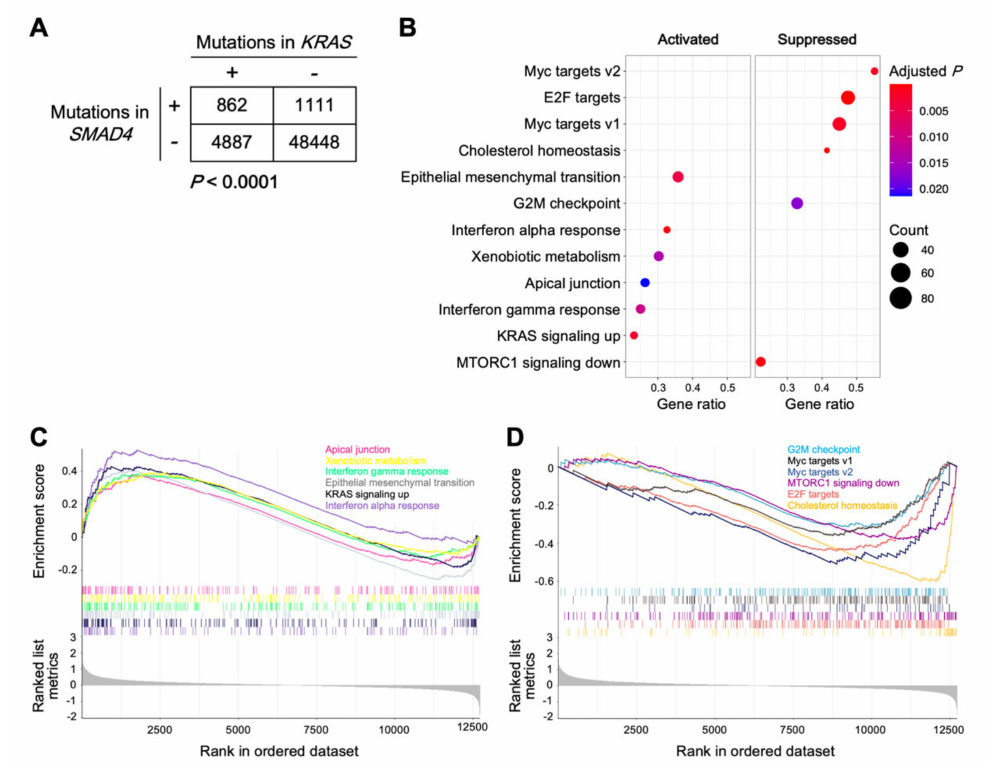
Figure 4. Analysis of the biological effect of KRAS and SMAD4 mutations. ( A ) KRAS and SMAD4 mutation status in 55,308 cancers registered in the cBioPortal, ‘curated set of non-redundant studies’. p values shown were calculated by Chi-squared test. ( B – D ) Gene Set Enrichment Analysis of bio- logical pathways up- or downregulated in KRAS mt / SMAD4 mt pancreatic cancer cell lines ( n = 11) compared with the other pancreatic cancer cell lines ( n = 31) registered to the Cancer Cell Line Ency- clopedia. B , dot plots. C and D , enrichment plots for up- and downregulated pathways,